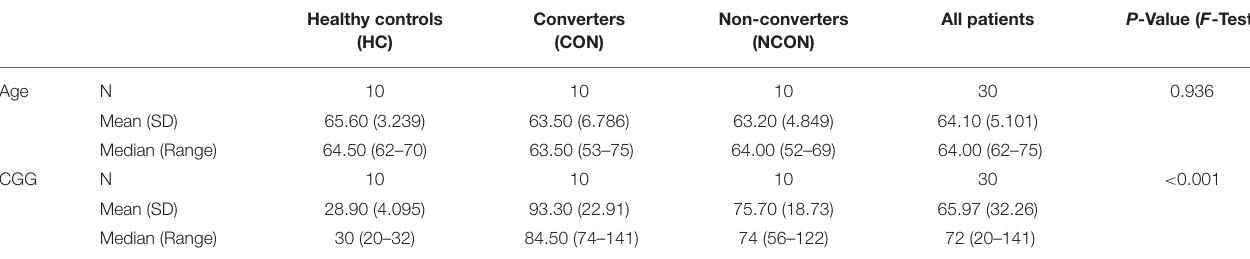
TABLE 1 | Demographic information on age and CGG repeats in three male participant groups: HC, CON and NCON. Healthy controls